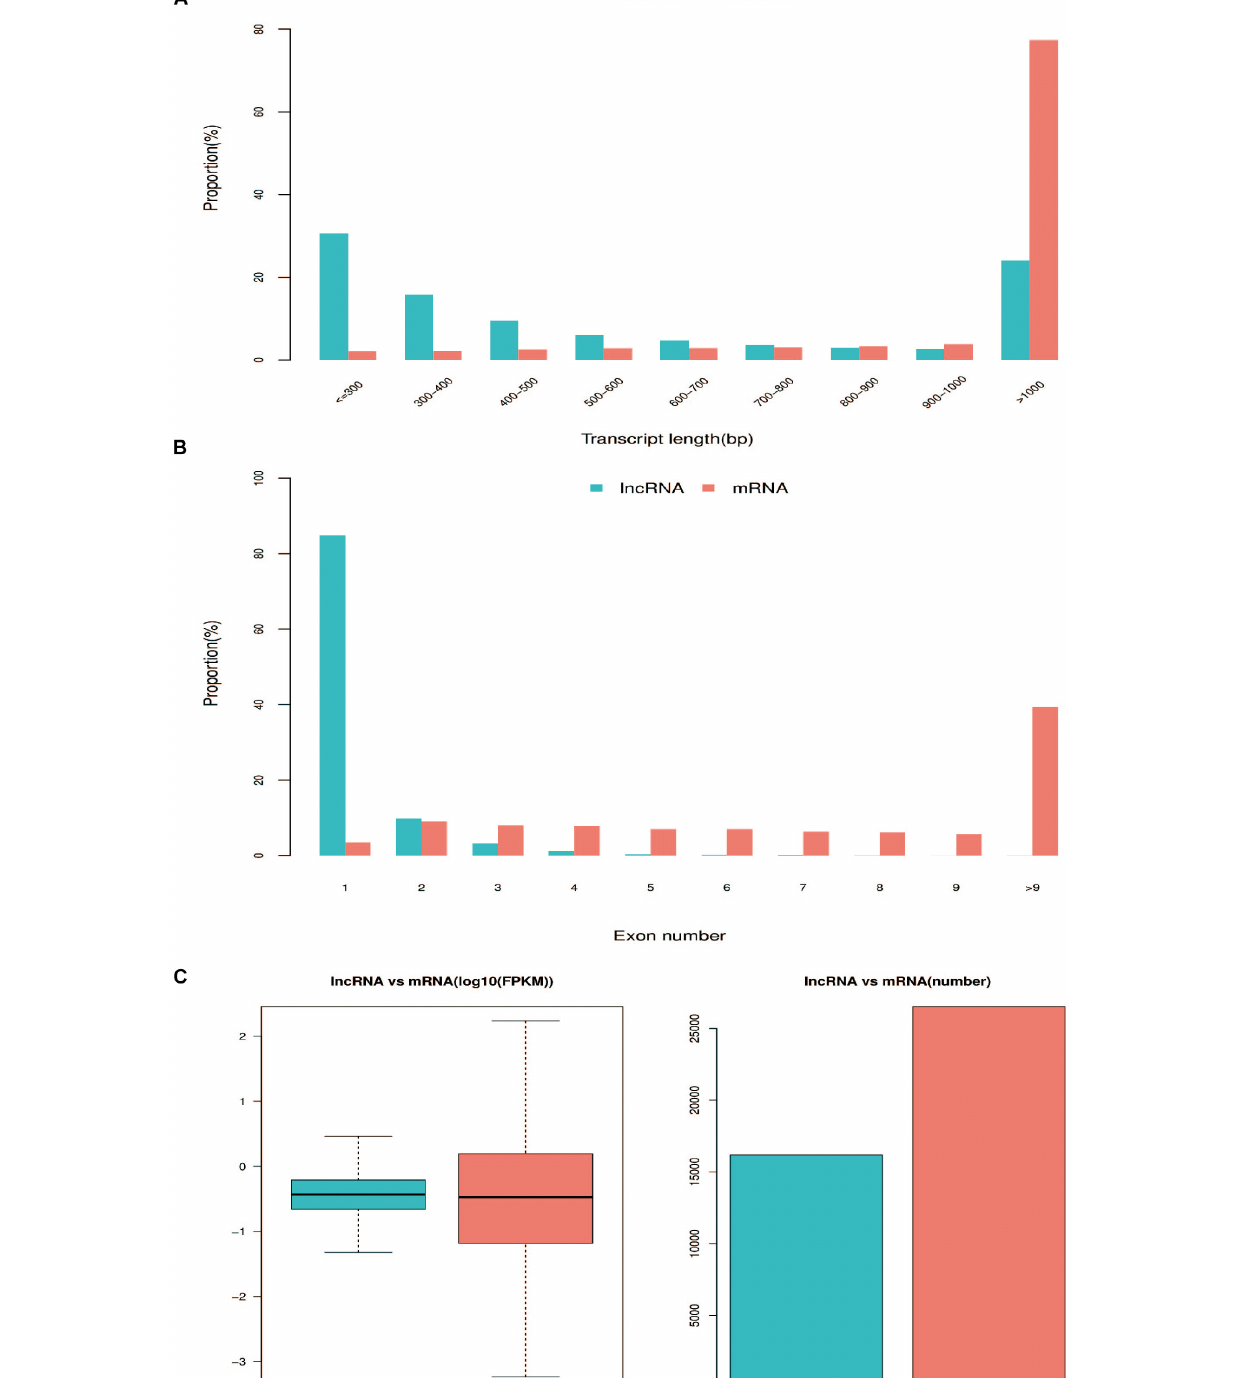
Frontiers in Physiology |